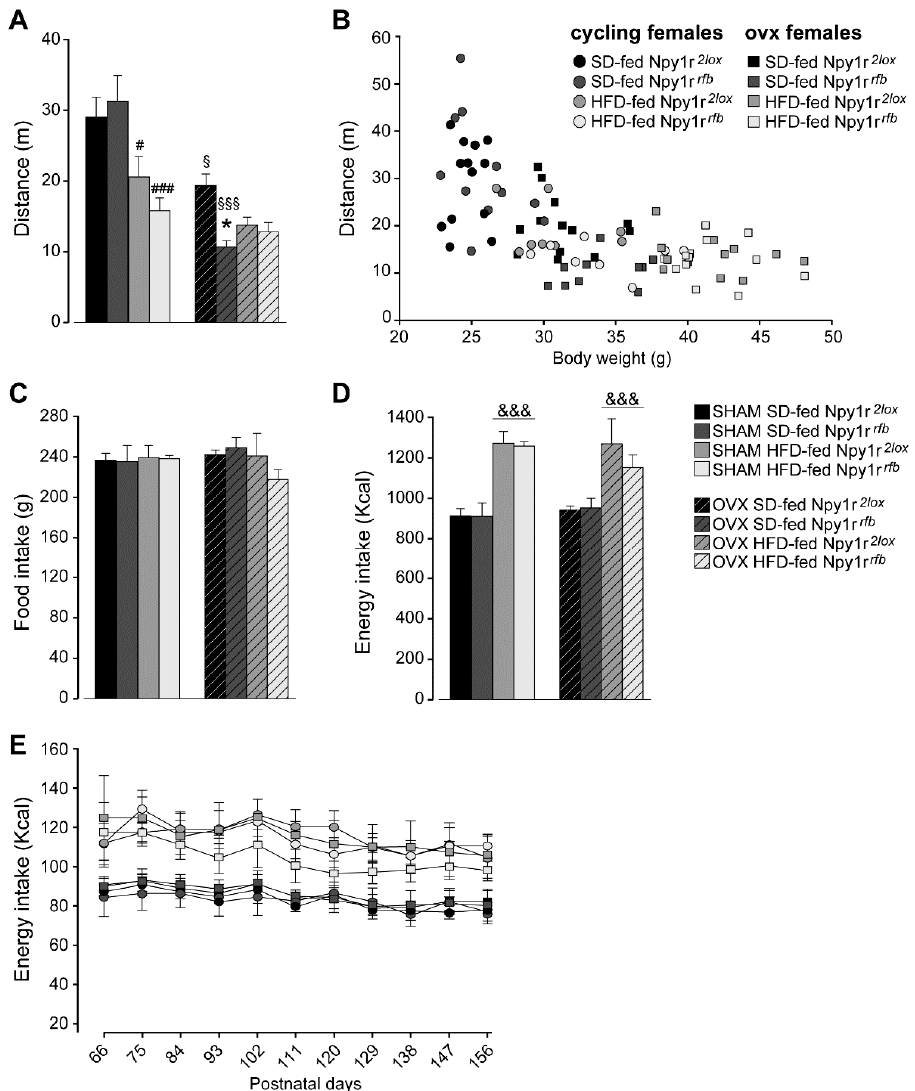
Figure 2. ( A ) Spontaneous locomotor activity of standard diet (SD)- and high-fat diet (HFD)-fed cycling and ovx Npy1r 2lox control and Npy1r rfb knockout female mice. Both HFD and ovariectomy significantly decreased locomotor activity (distance traveled, cm) of Npy1r 2lox and Npy1r rfb female mice. HFD-fed cycling and SD-fed ovx Npy1r rfb females showed significantly lower locomotor activity compared with their corresponding controls. Data are the mean ± SEM; n = 8–12 from 2 litters. # p < 0.05 versus SD-fed cycling controls; ### p < 0.001 versus SD-fed cycling Npy1r rfb female mice; § p < 0.05 versus SD-fed cycling controls; §§§ versus SD-fed cycling Npy1r rfb female mice; * p < 0.05 versus SD-fed ovx controls. ( B ) Correlation between locomotor activity and body weight of 156 days old SD- and HFD-fed cycling and ovx Npy1r 2lox and Npy1r rfb female mice. Data are the mean ± SEM; n = 6 from 3 litters. Food and energy intake of standard diet (SD)- and high-fat diet (HFD)-fed cycling and ovx Npy1r 2lox control and Npy1r rfb knockout female mice ( C – E ). ( C ) No significant differences of cumulative food intake (g) were observed among the different experimental groups. Data are the mean ± SEM; n = 4 from 3 litters. ( D ) HFD increased cumulative energy intake (Kcal) of cycling and ovx female mice, independently of the genotype. Data are the mean ± SEM; n = 6 from 3 litters. &&& p < 0.001 versus SD-females. ( E ) Nine-day cumulative energy intake (kcal) of SD- and HFD-fed cycling and ovx Npy1r 2lox control and Npy1r rfb knockout female mice during the metabolic challenge procedure (P66–156). Data are the mean ± SEM; n = 6 from 3